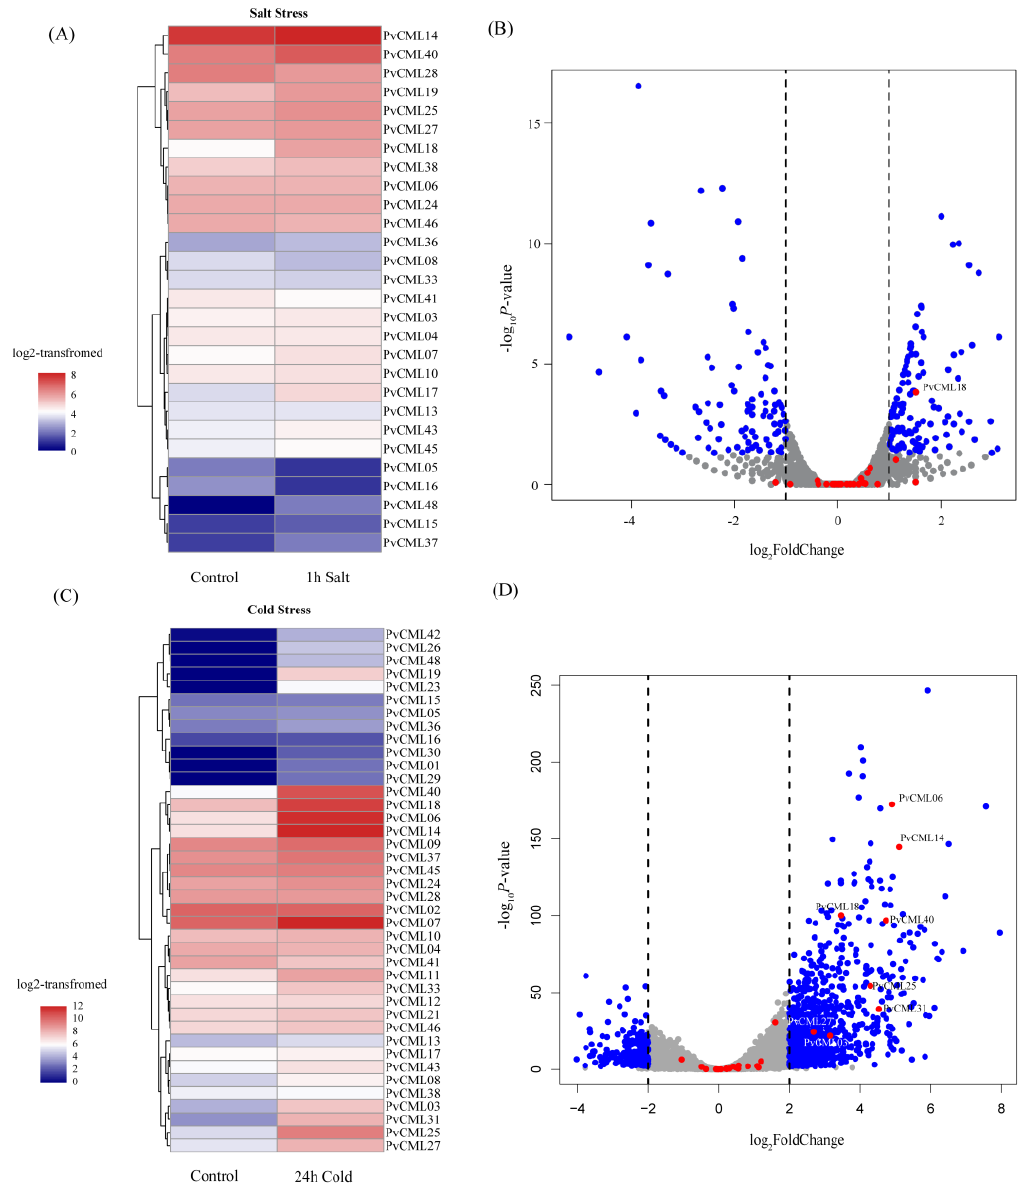
Figure 6. Expression pattern of PvCML genes under salt and cold stress conditions. ( A ). Heatmap of log2 – transformed RPKM of PvCML genes after 400 nM NaCl treatment. The colors changing from blue to red indicate the expression level transition from low to high. ( B ). Volcano plot displaying the differentially expressed genes after salt treatment. The blue dots represent genes differentially expressed (adjusted p < 0.05) in the 400 nM NaCl treatment group vs. the normal control group. The red dots represent PvCMLs. ( C ). Heatmap of log2 – transformed RPKM of PvCML genes after 6 °C cold treatment. The colors changing from blue to red indicate the expression level transition from low to high. ( D ). Volcano plot displaying the differentially expressed genes after 6 °C cold treatment. The blue dots represent genes differentially expressed (adjusted p < 0.05) in the 6 °C treatment group vs. the normal control group. The red dots represent PvCMLs.